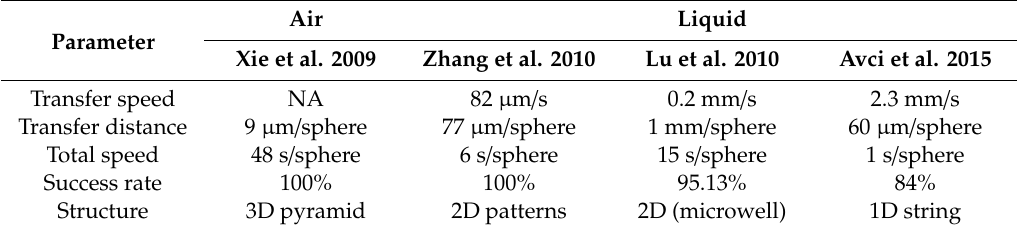
Table 1. Automated high speed pick-and-place method in air and liquid.